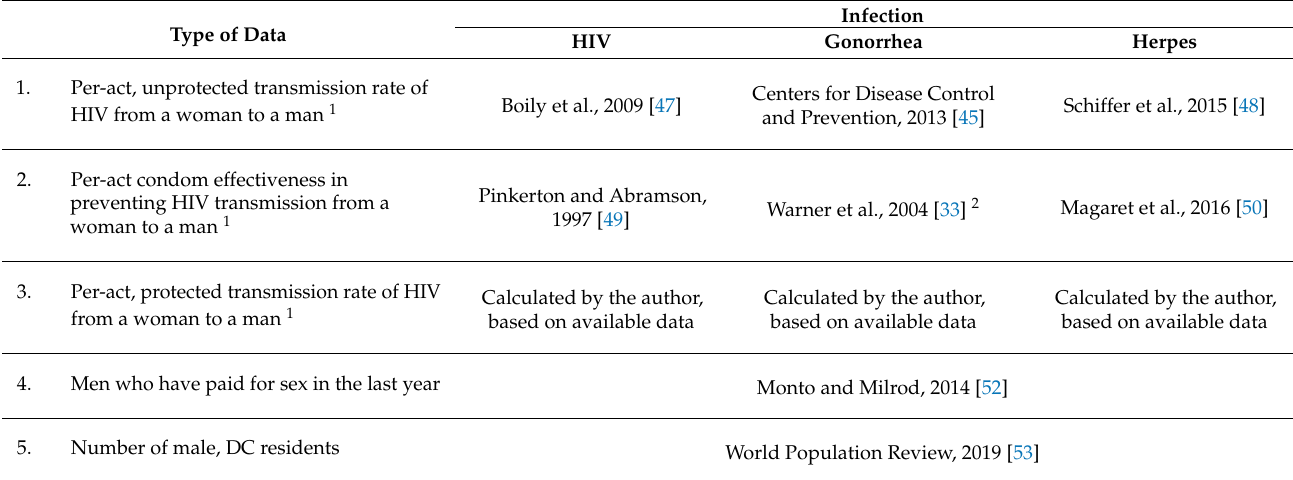
Table 11. Sources of data used to calculate health sector savings due to averted cases of HIV, gonorrhea, and herpes in clients following decriminalization.